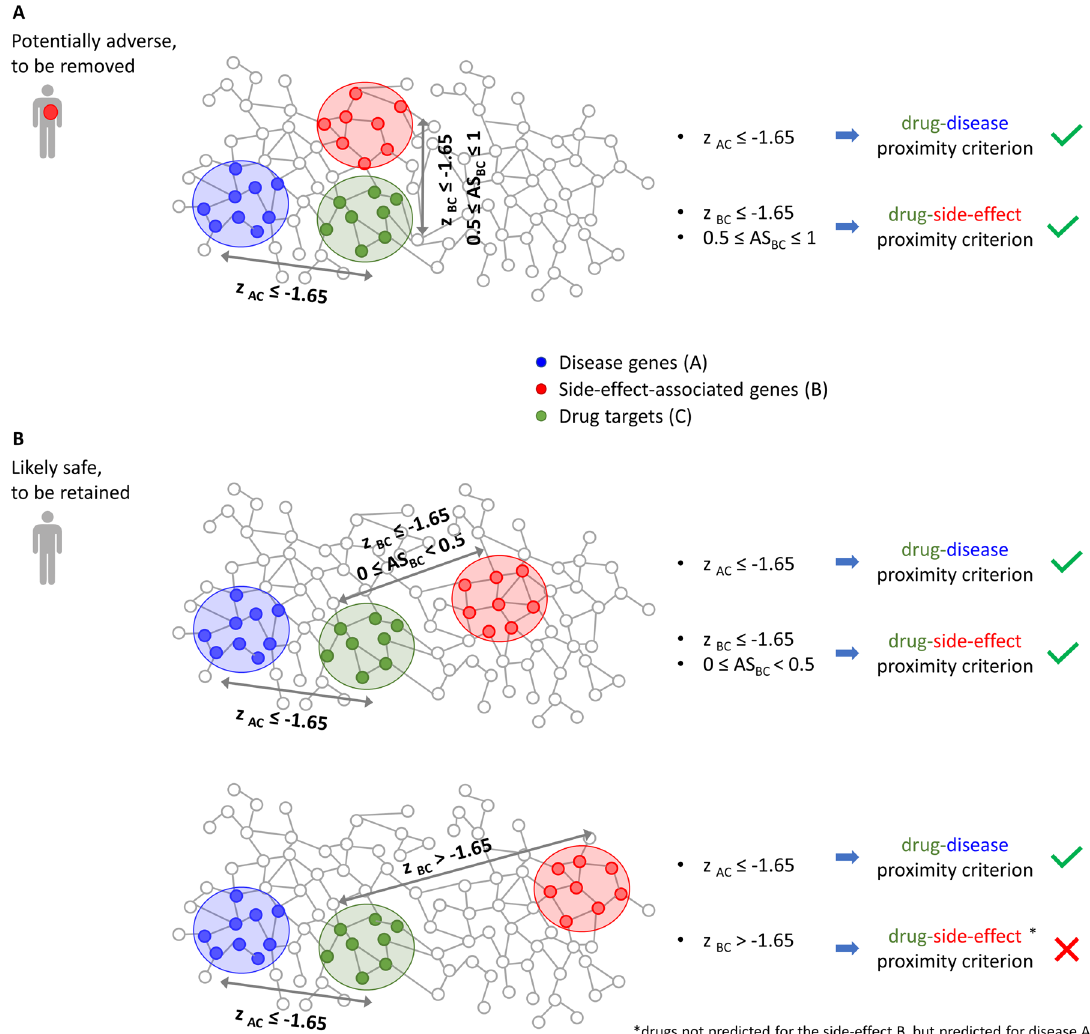
Fig. 2 Study design. The fi gure depicts the topological relationships among the drug module (green), the disease module (blue), and the side-effect module (red) for a drug to be removed from (panel A ) or retained for (panel B ) consideration. The z AC and z BC denote the z -score normalized network proximity between the targets of the drug (C) and the genes associated with the disease ( A ) and with the side-effect ( B ), respectively. AS BC is the adjusted similarity between the drug targets (C) and the side-effect-associated genes ( B ). In the bottom row, the AS BC value is not reported for drugs with z BC > − 1.65 since they are removed independent of their AS BC